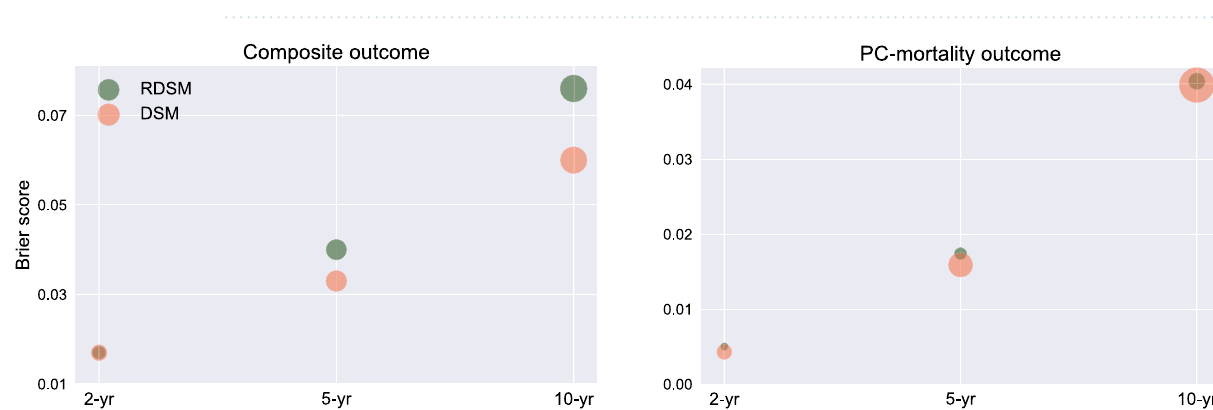
Figure 4. C td with 95% confidence interval (CI) for all tested models at near (2-year), mid (5-year) and long (10-year) time horizons for composite (left) and prostate cancer (PC)-mortality (right).